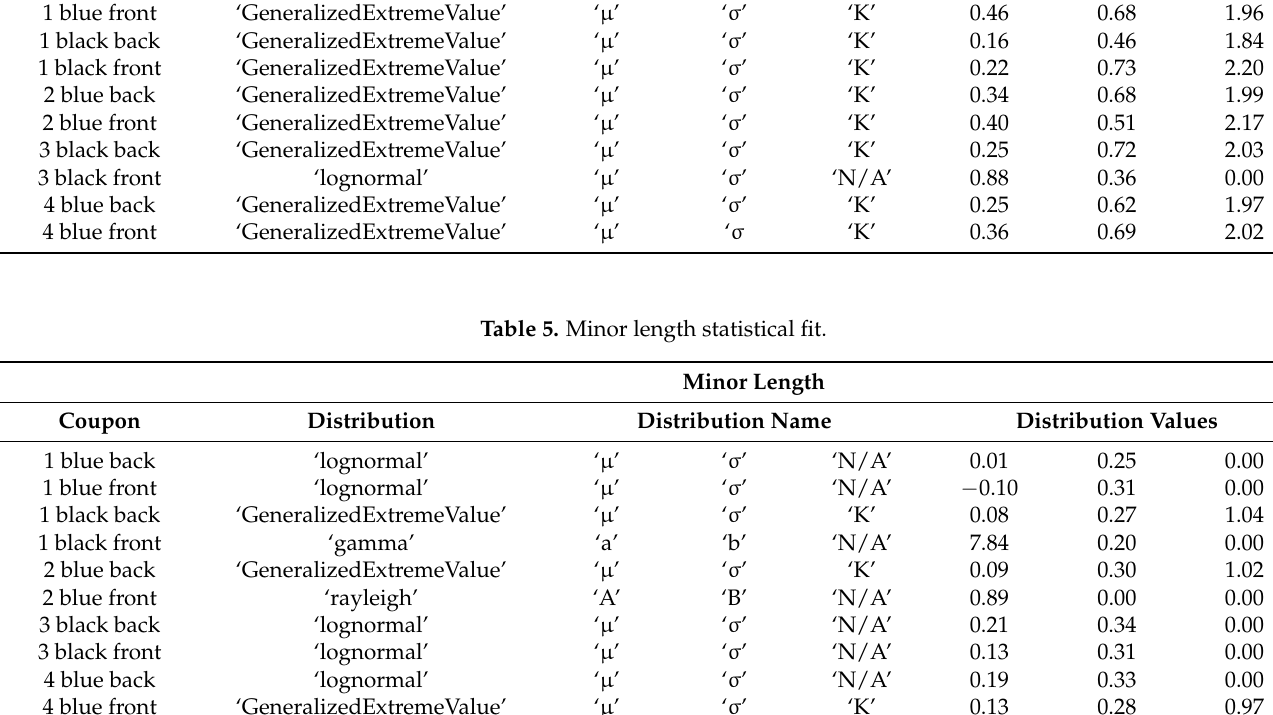
Table 4. Major length statistical fit.